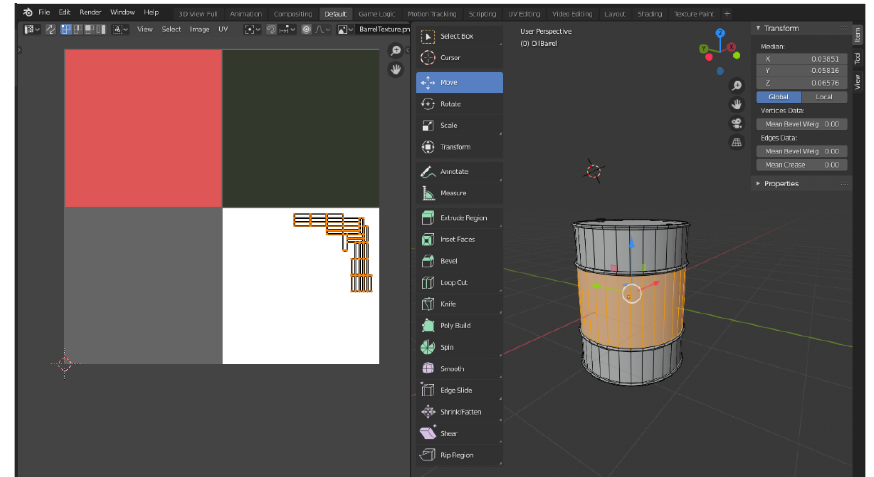
Figure 3. Selected faces on desired color inside the